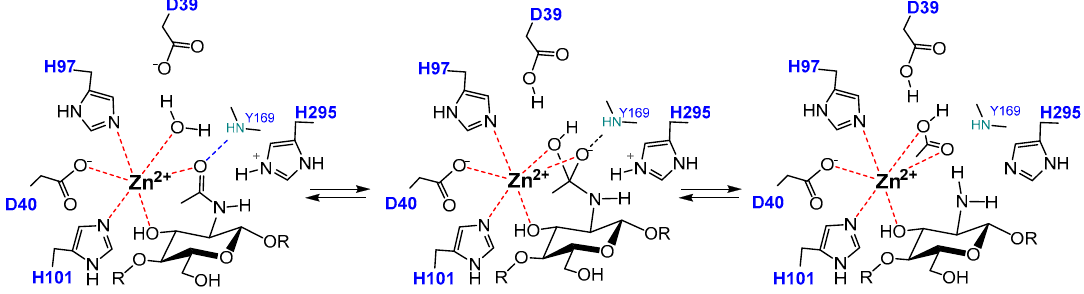
Figure 5. Metal-assisted general acid/base mechanism proposed for CE4 deacetylases. Scheme based on the 3D structure of the enzyme·substrate complex VcCDA D39S ·DP2 [61]. D39 is the general base and His295 is the general acid.